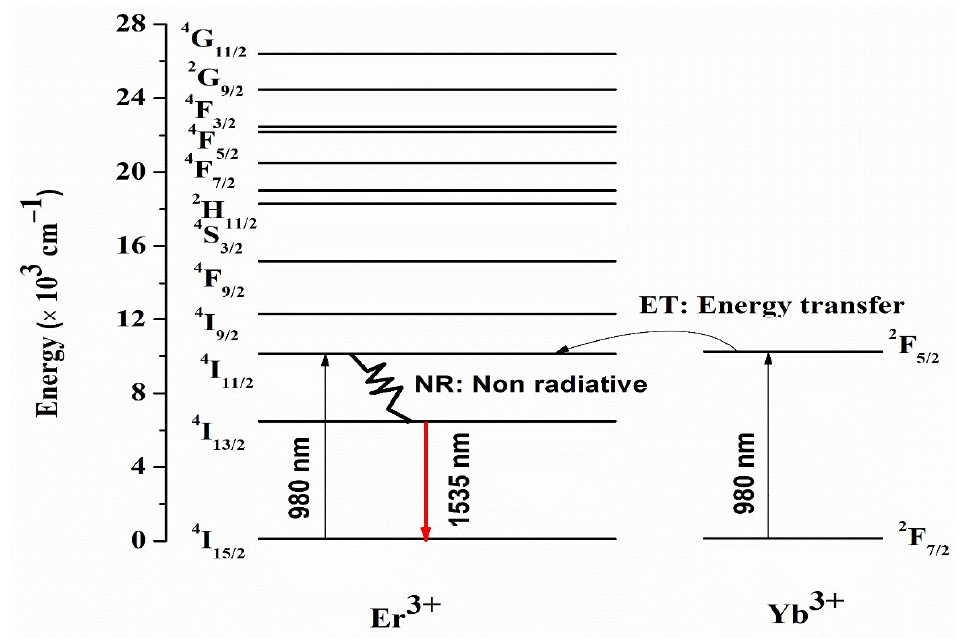
Figure 7. Energy level scheme of Er 3+ and Yb 3+ ions in ZBB